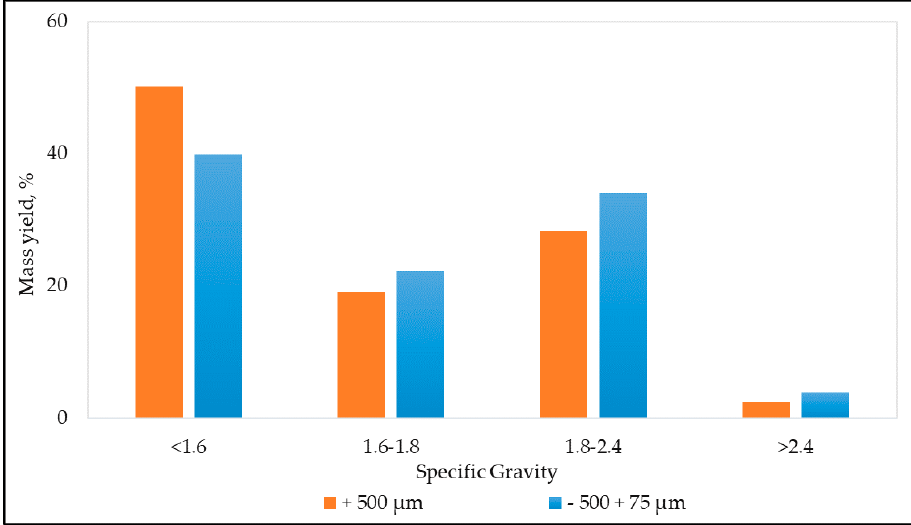
Figure 1. Yield of different specific gravities products for coarse and fine samples.